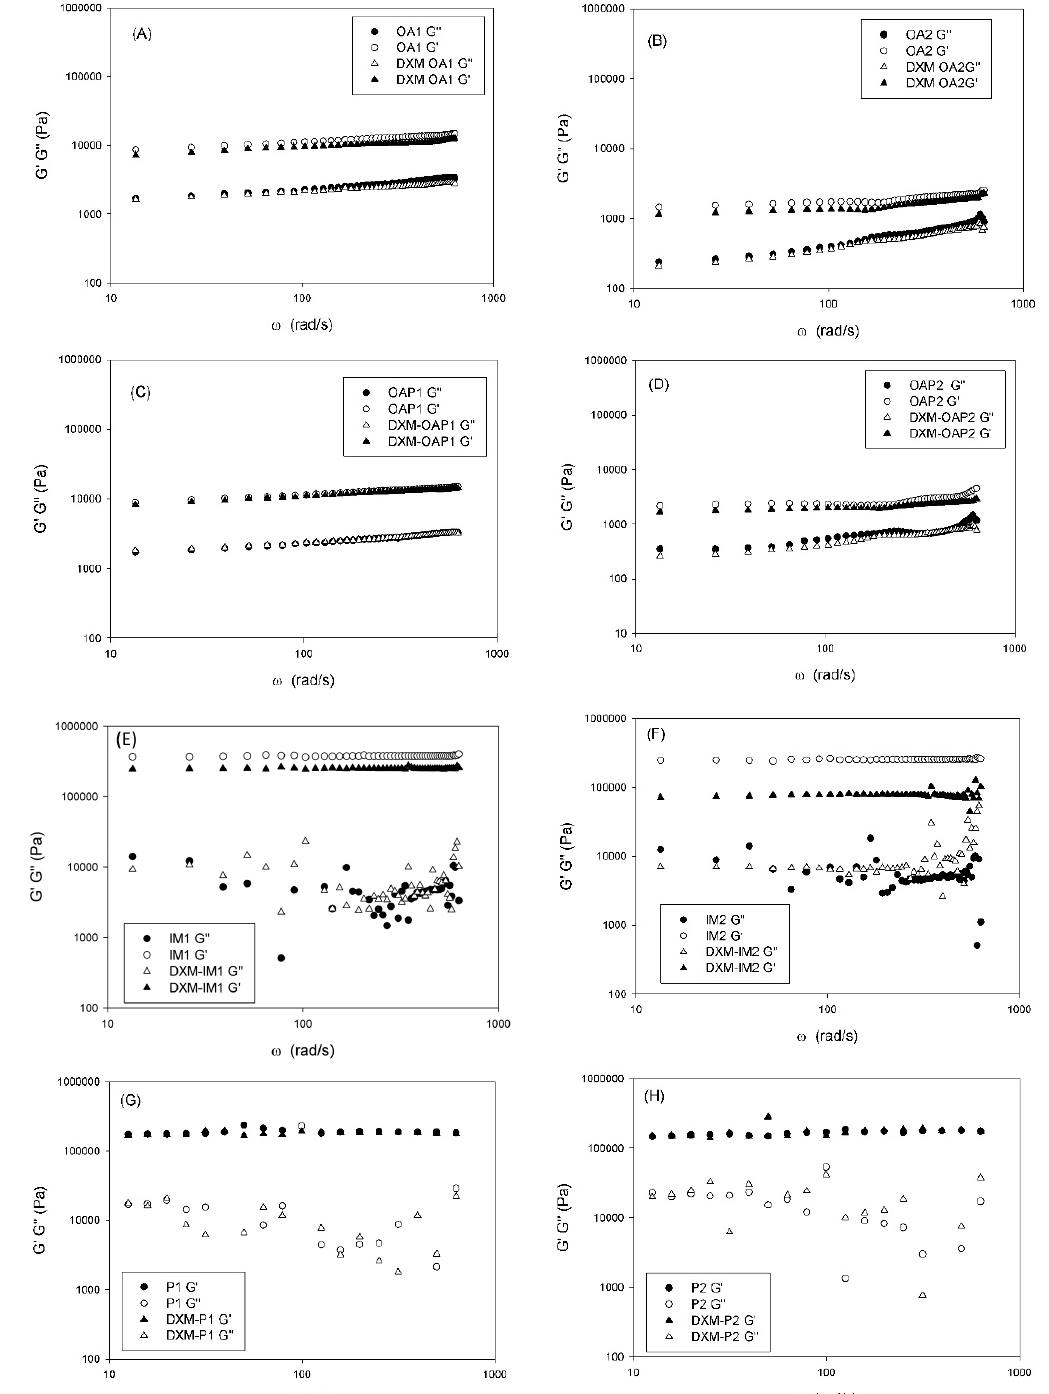
Figure 5. The frequency sweep profile of the storage (G ′ ) and loss moduli (G ′′ ) of samples at 25 °C. DXM loaded formulations. The sample compositions are described in Table 1.